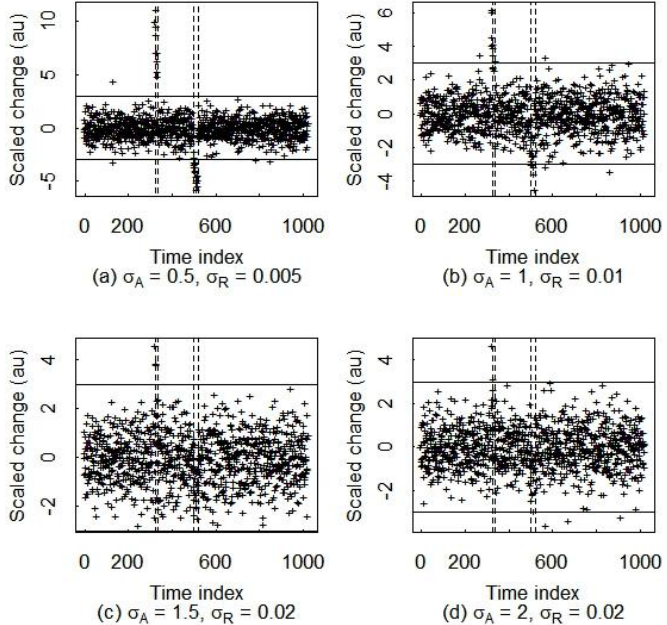
Figure 7. The scaled change arising from the Haar-wavelet coefficient monitoring for increasing values of σ and σ in Equation (1) in subplots ( a – d ). Note that both the gradual A R shipment and the gradual receipts are easily detected for ( a – d ) as σ two true change regions are indicated with vertical dashed